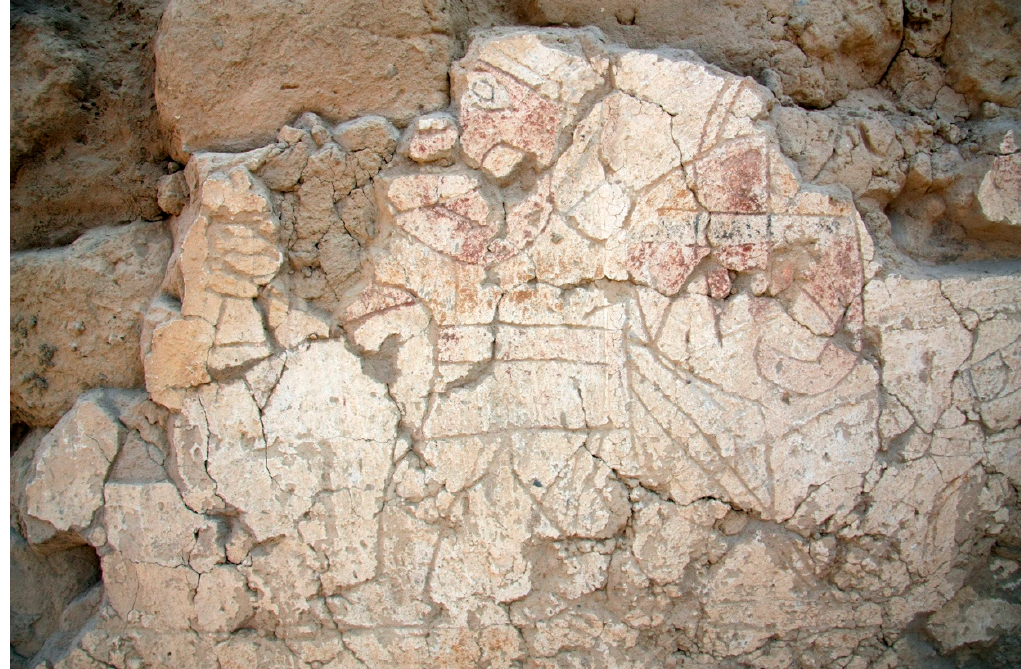
Figure 8. Bat attendant holding a ceremonial cup in Mural E at Pañamarca (Courtesy of Lisa Trever).